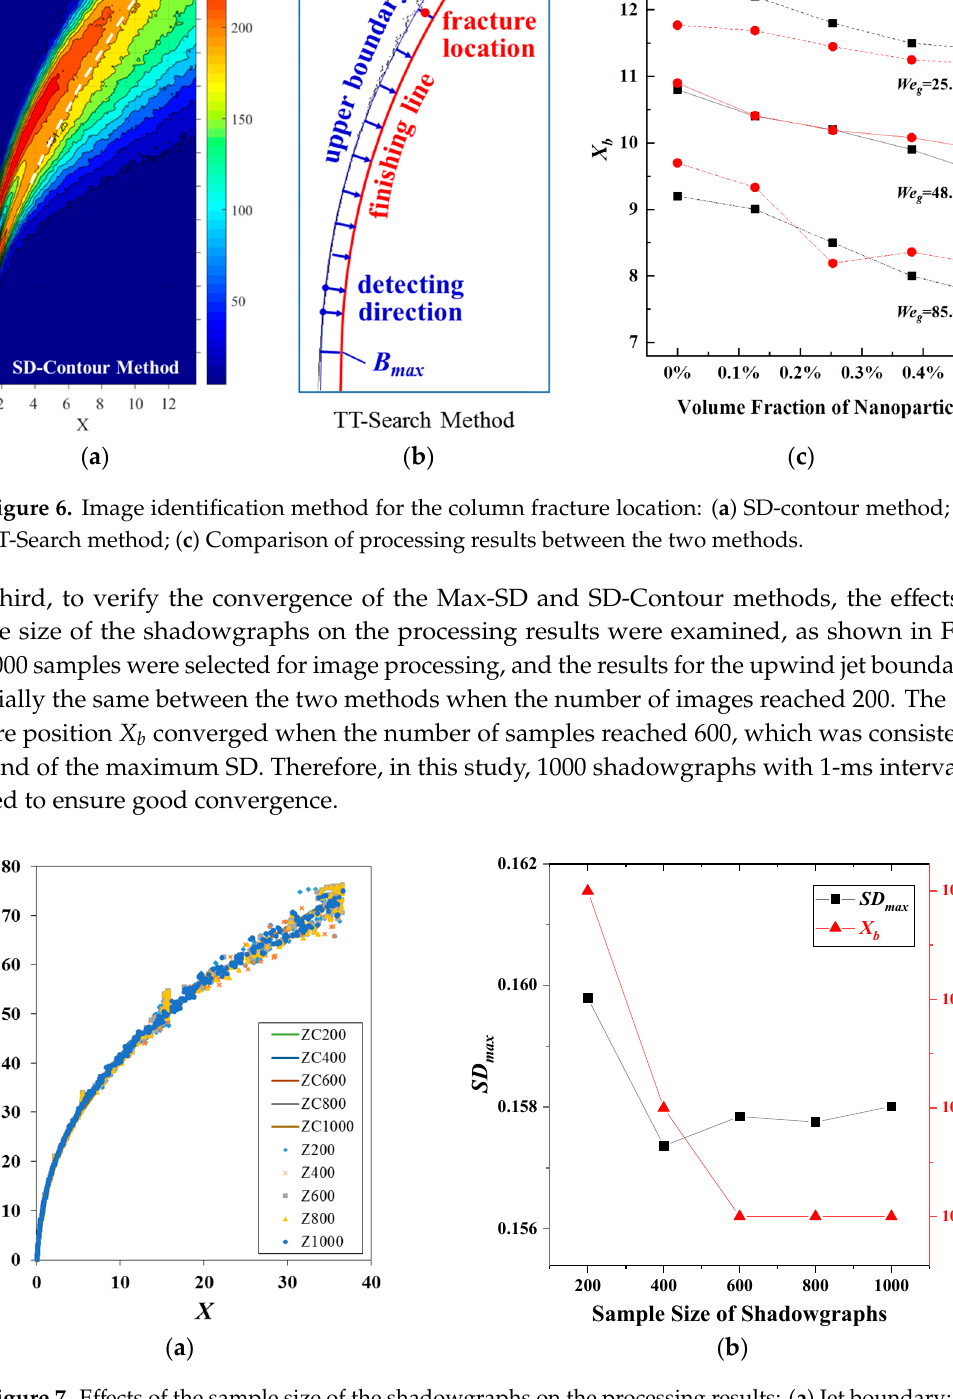
Figure 6. Image identification method for the column fracture location: ( a ) SD-contour method; ( b ) TT-Search method; ( c ) Comparison of processing results between the two methods.